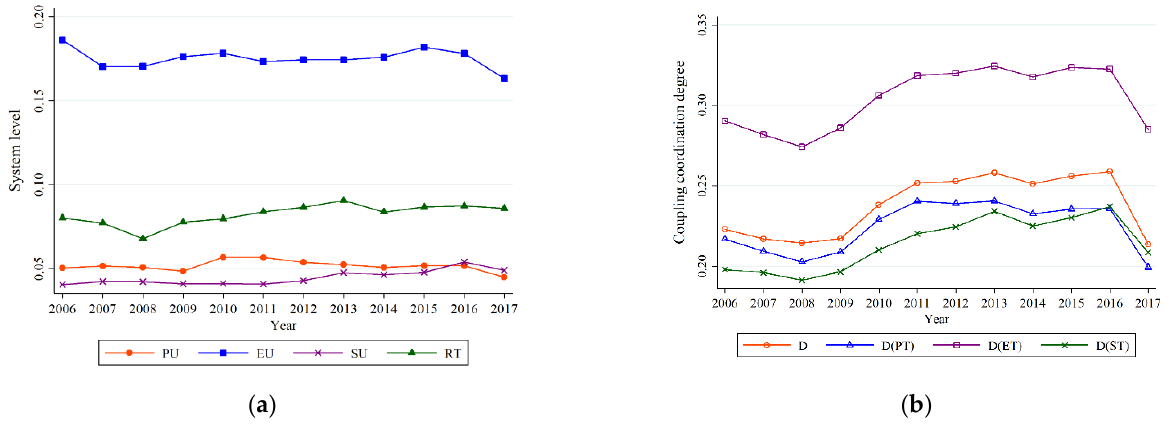
Figure 2. The levels of population urbanization, economy urbanization, spatial urbanization, and rail transit ( a ), the mean values of coupling coordination degree ( b ).